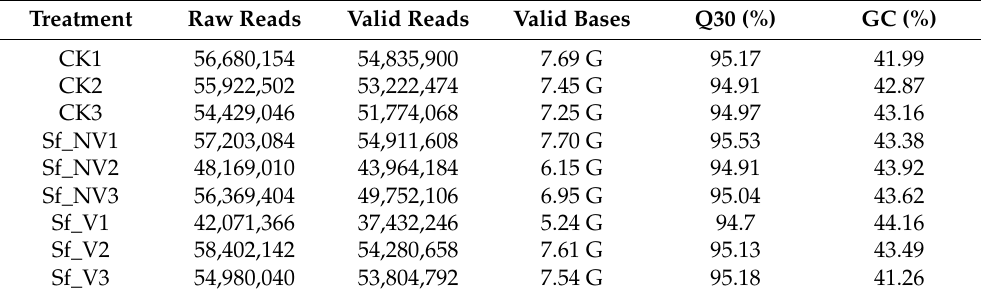
Table 1. Summary of RNA-seq metrics from the transcriptome sequencing data of S. furcifera females. Treatment Raw Reads Valid Reads Valid Bases Q30 (%)